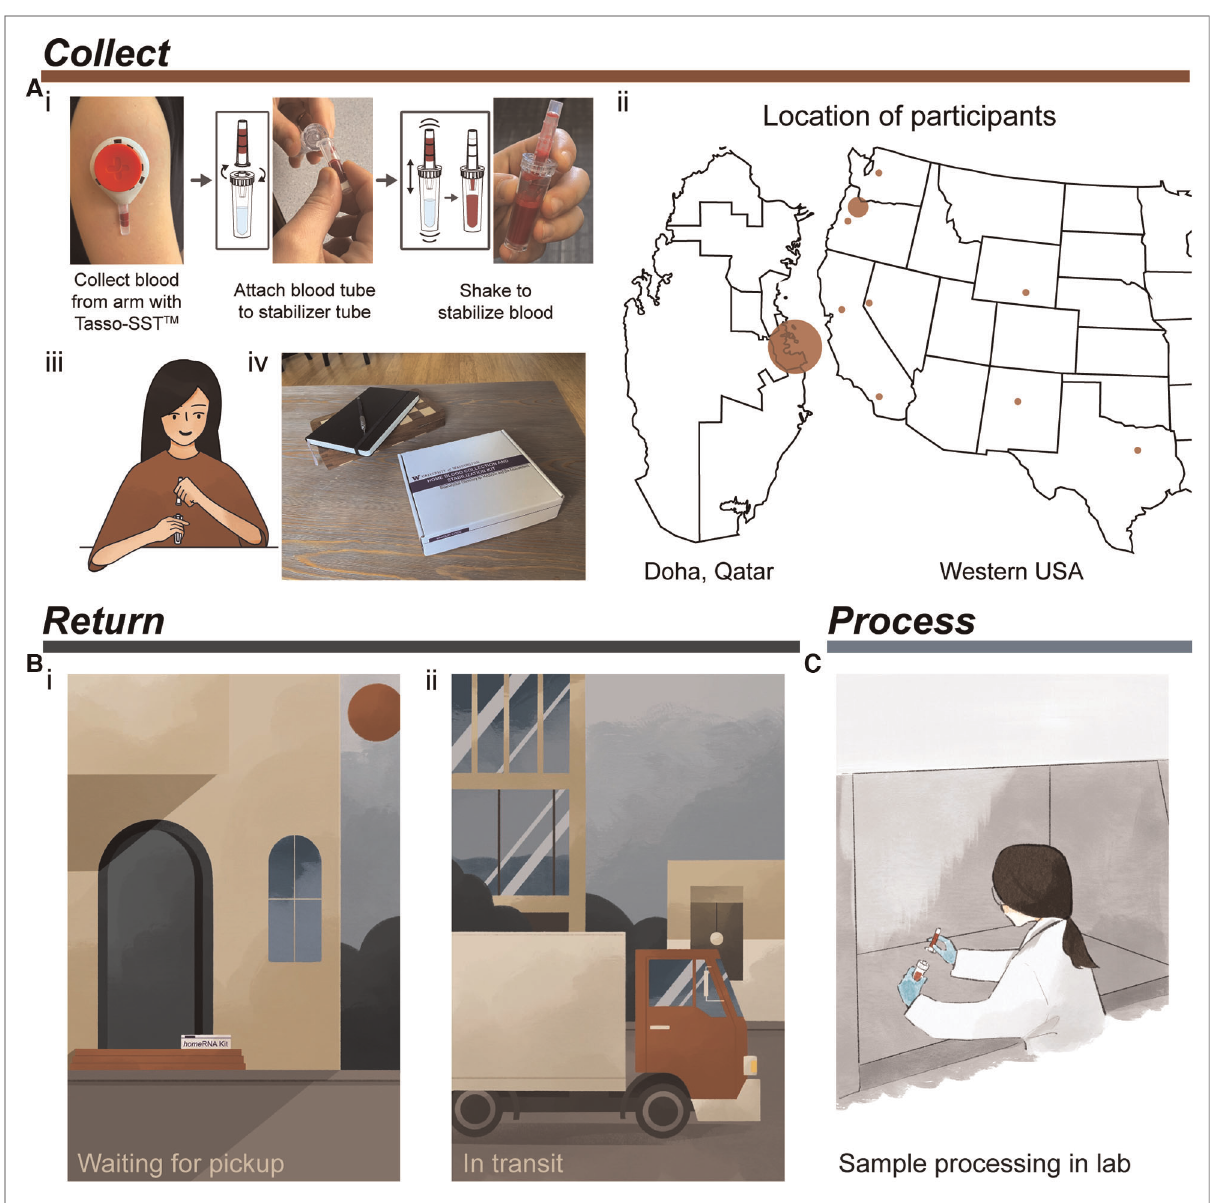
FIGURE 1 Typical process for using home RNA from collection to processing of samples. ( A ) Collection and stabilization of blood using home RNA. (i) Process of collecting blood from the upper arm with Tasso device and stabilizing the sample with the home RNA custom stabilizer tube. Image was reprinted with permission from Haack, Lim et al. home RNA: A Self-Sampling Kit for the Collection of Peripheral Blood and Stabilization of RNA. Anal. Chem. 2021, 93, 39, 13196 – 13203. Copyright 2021 American Chemical Society (23). (ii) Map depicting locations of participants in the small pilot studies conducted in Qatar and the Western and South Central USA. Note, participants in Qatar collected samples themselves in a lab setting. (iii) illustration demonstrating a participant connecting the Tasso blood tube and the home RNA stabilizer tube, (iv) home RNA kit on a coffee table, depicting a home setting for blood collection. ( B ) Illustration demonstrating two possible locations where samples may be exposed to high temperatures including (i) located on a front porch waiting to be picked up (which was the pickup location for many participants in the Western and South Central USA pilot study) and (ii) in transit in a delivery truck or courier service. ( C ) fi nal step of sample processing for downstream analysis in a laboratory